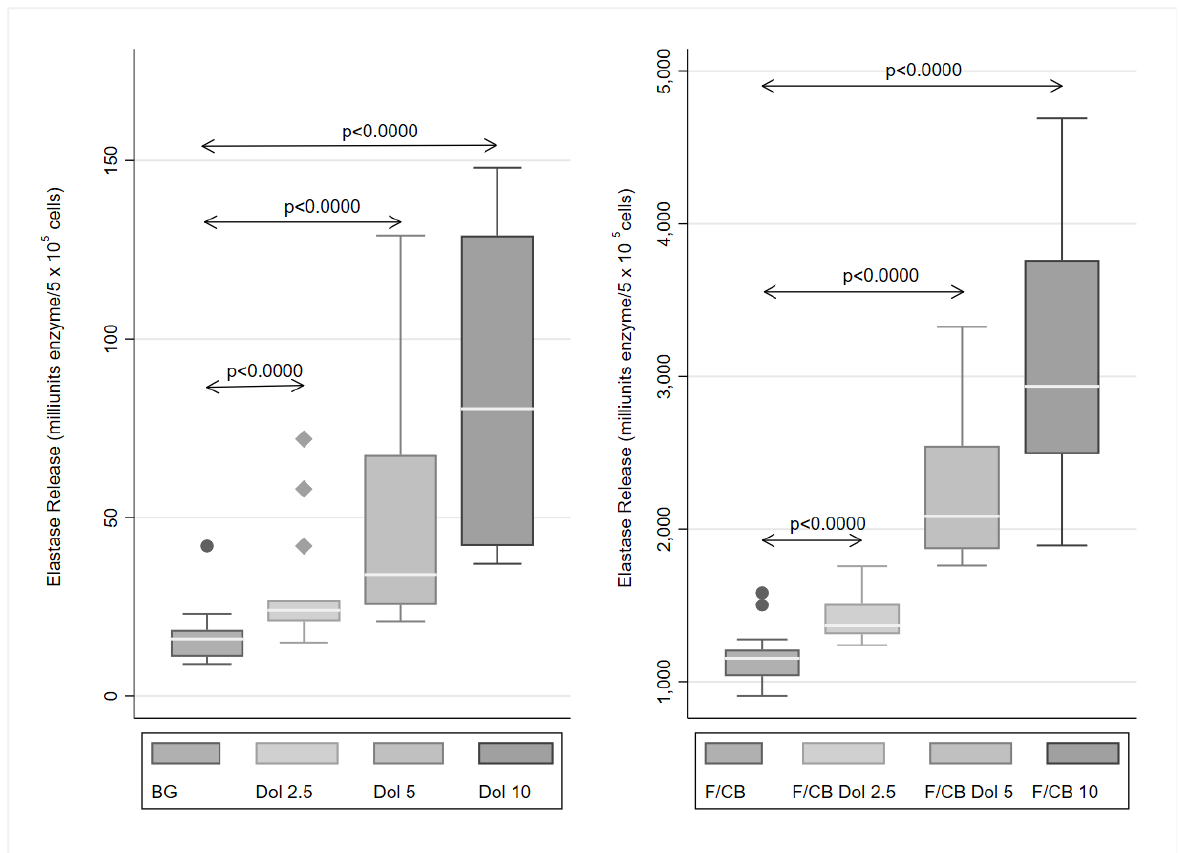
Figure 2. Effects of dolutegravir (Dol, 2.5 – 10 μ g/mL) on the release of elastase from unstimulated neutrophils (spontaneous release), as well as from cells activated with FMLP (0.1 μ M)/cytochalasin B (1 μ M) (F/CB). The results ( n = 4 donors with 5 replicates for each experiment) are expressed as Box and Whisker plots (milliunits/5 × 10 5 cells). “BG” (Background) refers to the unstimulated